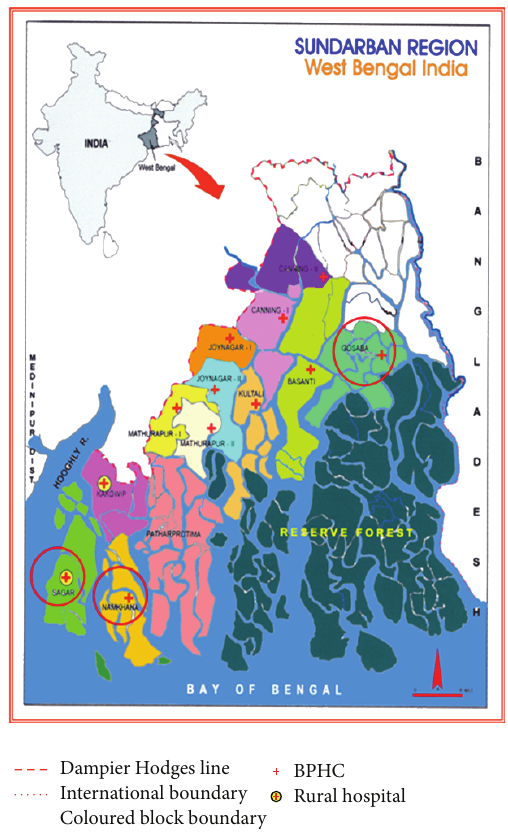
Figure 1: Sundarban region under the South 24 Parganas, showing the study blocks (not to